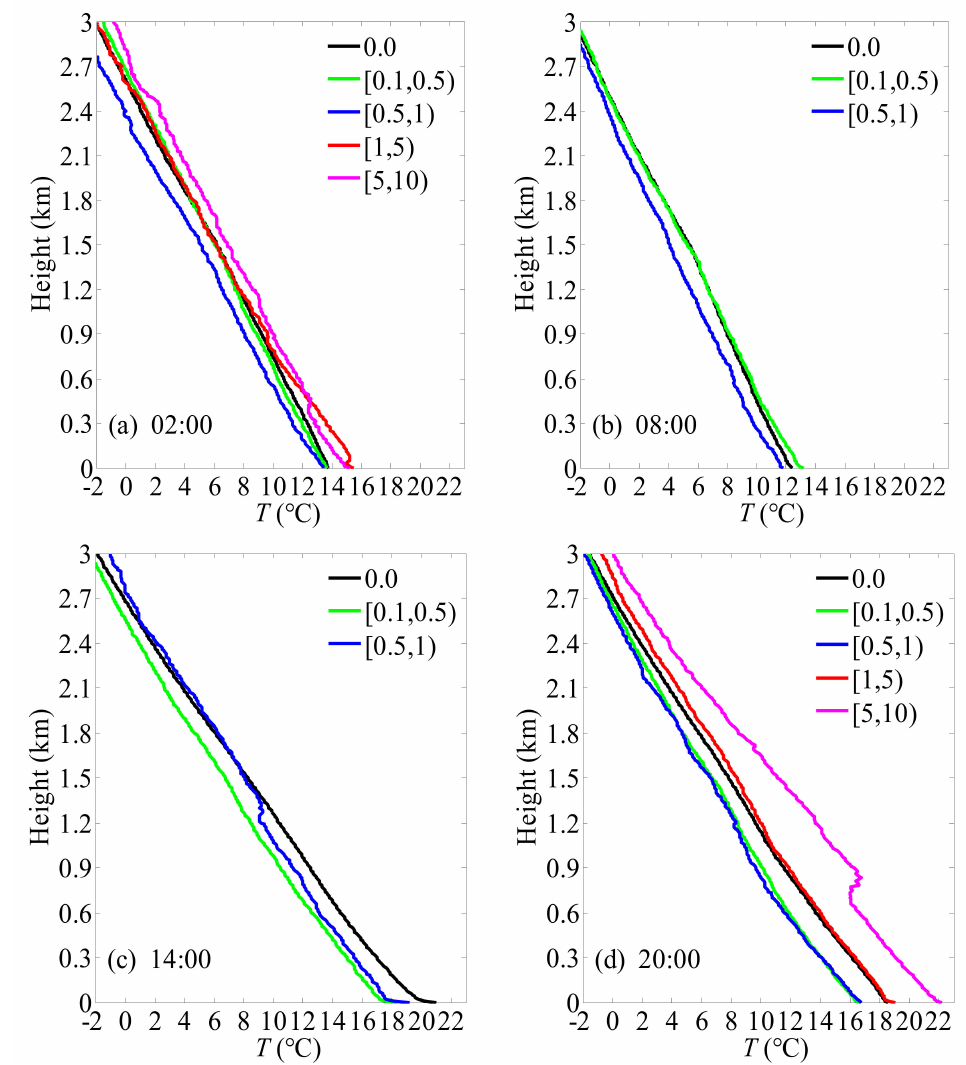
Figure 4. Atmospheric temperature profiles in different precipitation grades at launch times in Jiulong from 2013–2020. ( a ) 02 LST, ( b ) 08 LST, ( c ) 14 LST and ( d ) 20